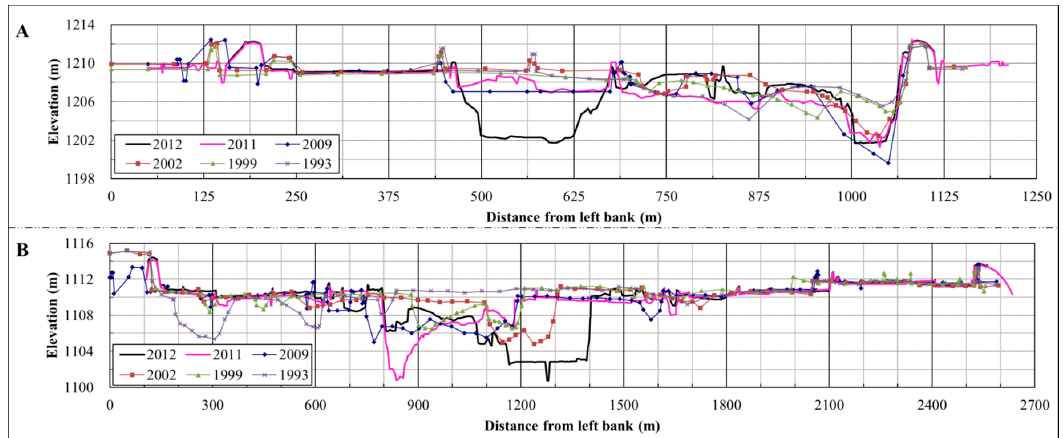
Figure 9. Combined graphs for the actual measured multi-year cross-sections at certain locations in the: ( A ) Weining Reach; and ( B ) Qingshi Reach of the NRYR.